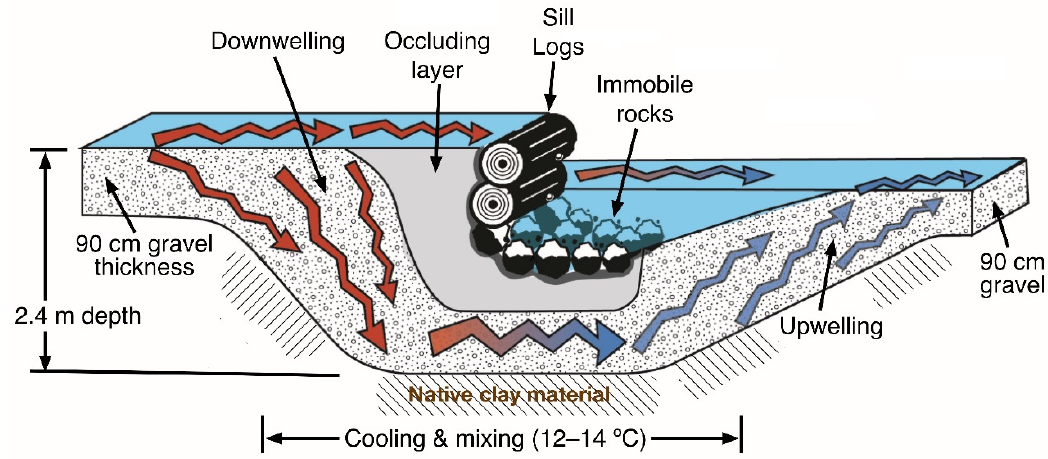
Figure 6. Longitudinal cutaway view of a plunge-pool structure, showing direction of surface and hyporheic flow.